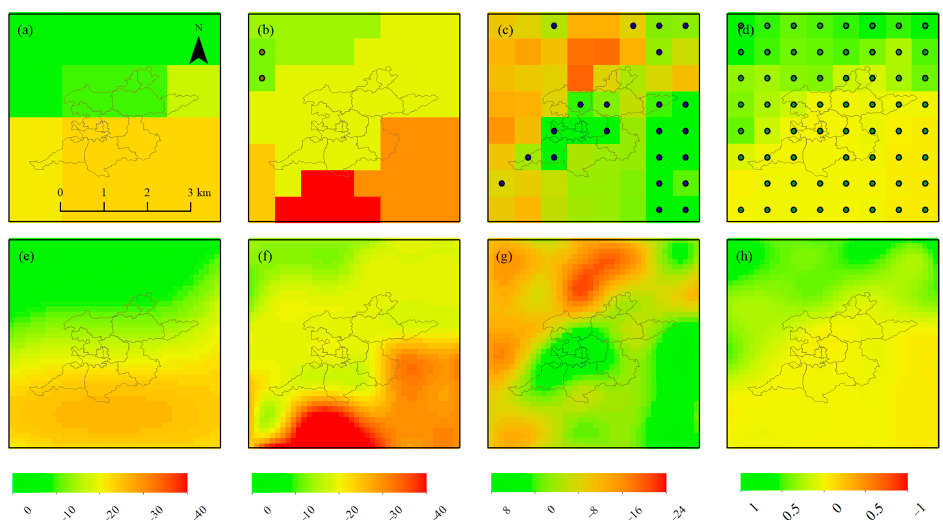
Figure 10. Annual trends of variables retrieved with GRACE and GLDAS during 2017–2020. ( a ) 0.5° JPL-TWSA; ( b ) 0.25° CSR-TWSA; ( c ) 0.25° NOAH-SMSA; ( d ) 0.25° NOAH-SWSA; ( e – h ) the interpolated results at 0.05° corresponding to ( a – d ), respectively. The grey dots represent areas with non-significant trends ( p ≥ 0.05).